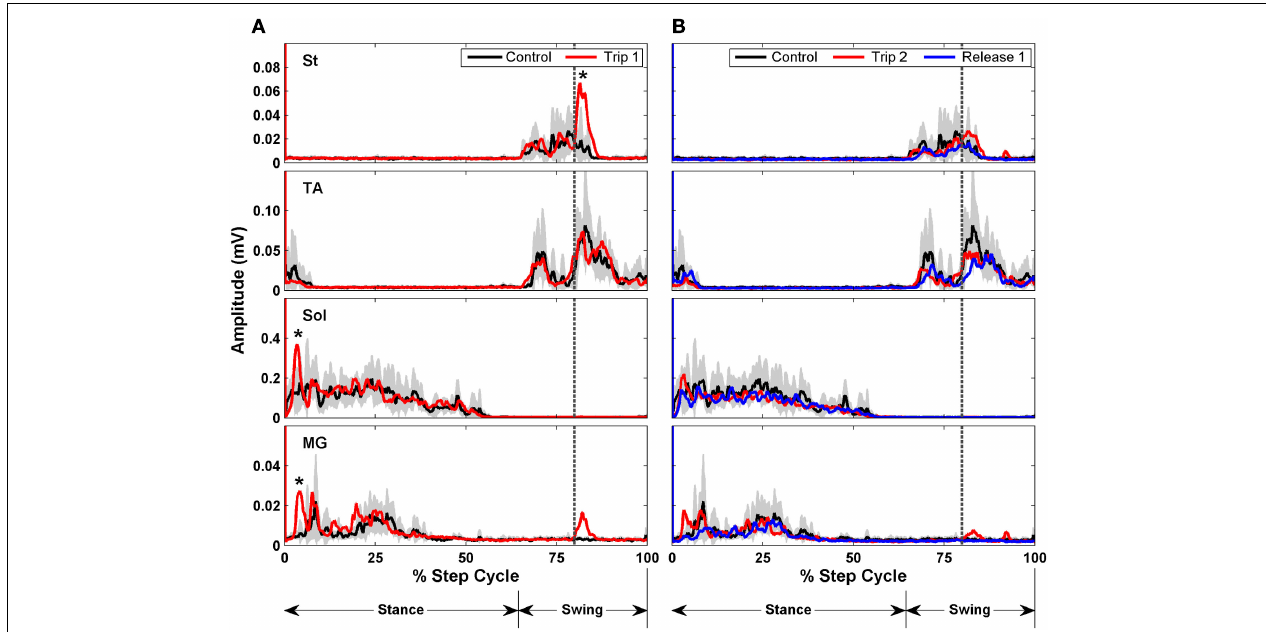
FIGURE 9 | Rectified EMG bursts for the St,TA, Sol, and MG of control (black traces, 10 steps precedingTrip 1),Trip 1 [red traces in (A) 20 steps],Trip 2 [red traces in (B) 20 steps], and release 1 [blue traces in (B), 20 steps] sequences. The gray shading is the SD for the control sequence. Muscle abbreviations, same as in Figure 8 . *Significantly higher than in the control and release